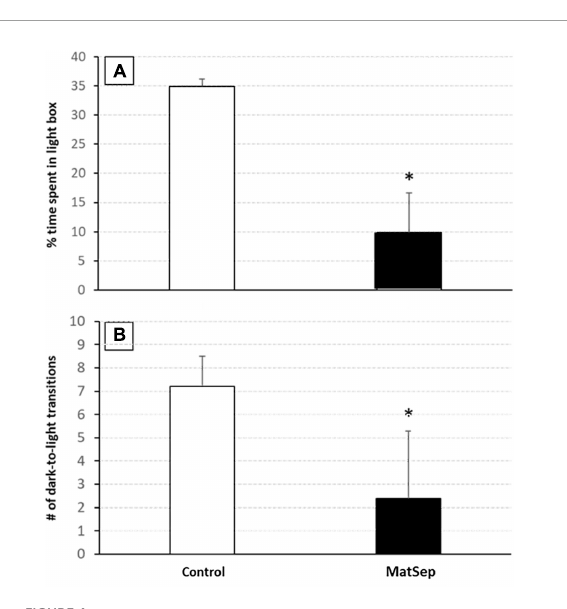
FIGURE4 Anxiety-like behavior is increased in MatSep adults. Exposure to MatSep in the neonatal period is associated with increased anxiety-like behavior in adulthood, as evidenced by a decreased amount of time spent in the light portion of the light/dark box (A) , and a reduced number of transitions made from the dark to the light areas of the testing apparatus (B) demonstrated by MatSep animals. ∗ p ≤ 0.05; n =